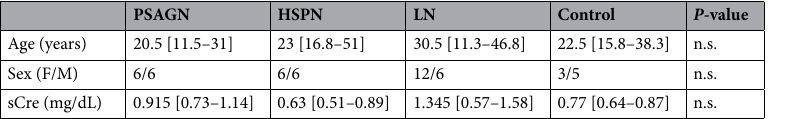
Table 1. Clinical characteristics. PSAGN, post-streptococcal acute glomerulonephritis; HSPN, Henoch– Schönlein purpura nephritis; LN, lupus nephritis; sCre, serum creatinine level; n.s., not significant.